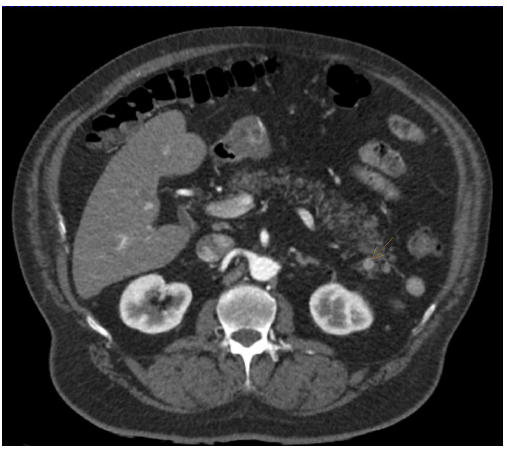
Figure 3: Axial CT scan of a neuroendocrine pancreatic tumour in- cidentally diagnosed in a 67-year old ED patient.